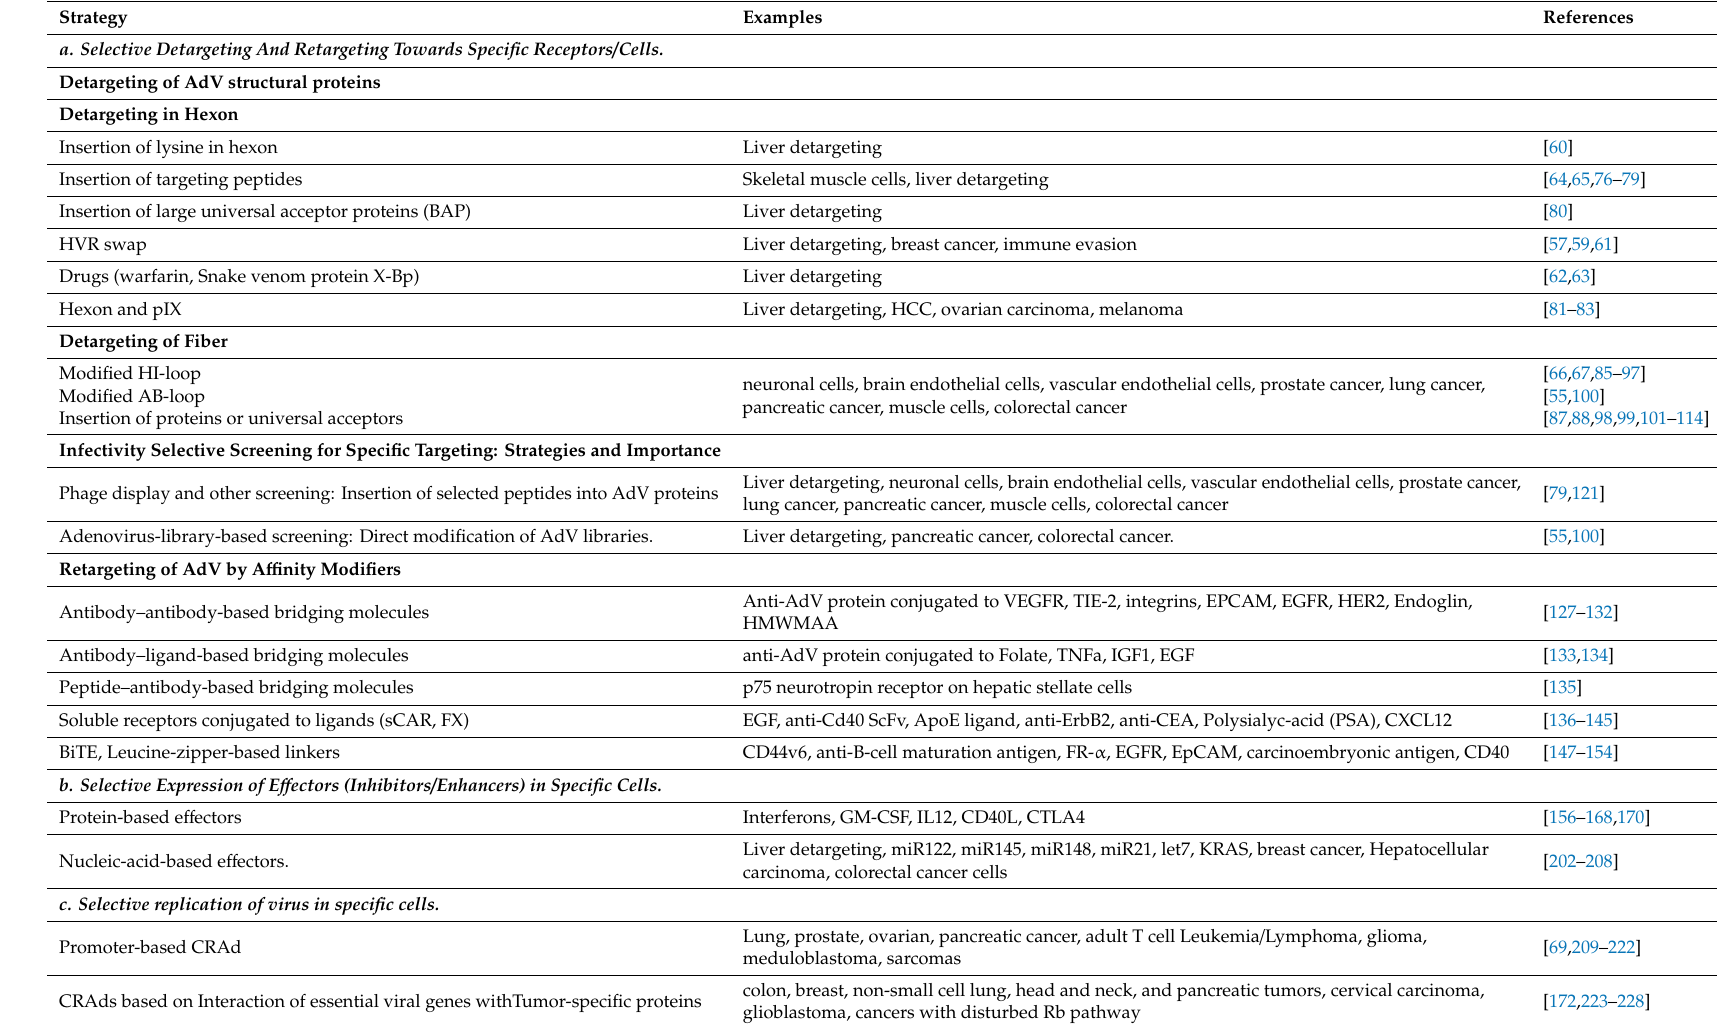
Table 1. Detargeting and retargeting strategies with representative